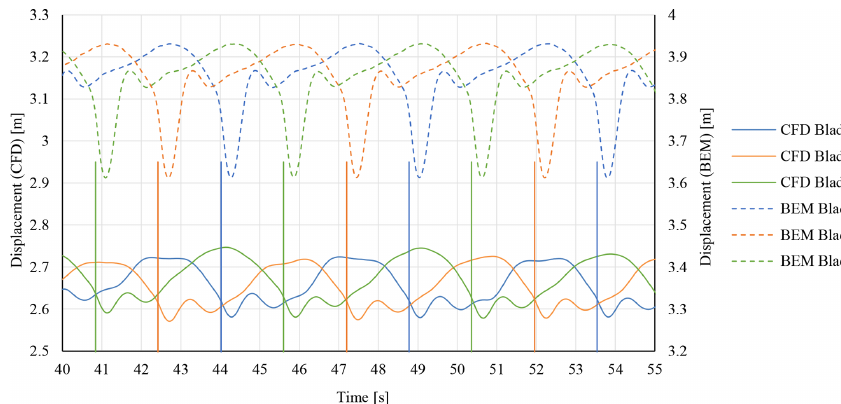
Figure 14. Blade’s flapwise displacements of the CFD and BEM models.